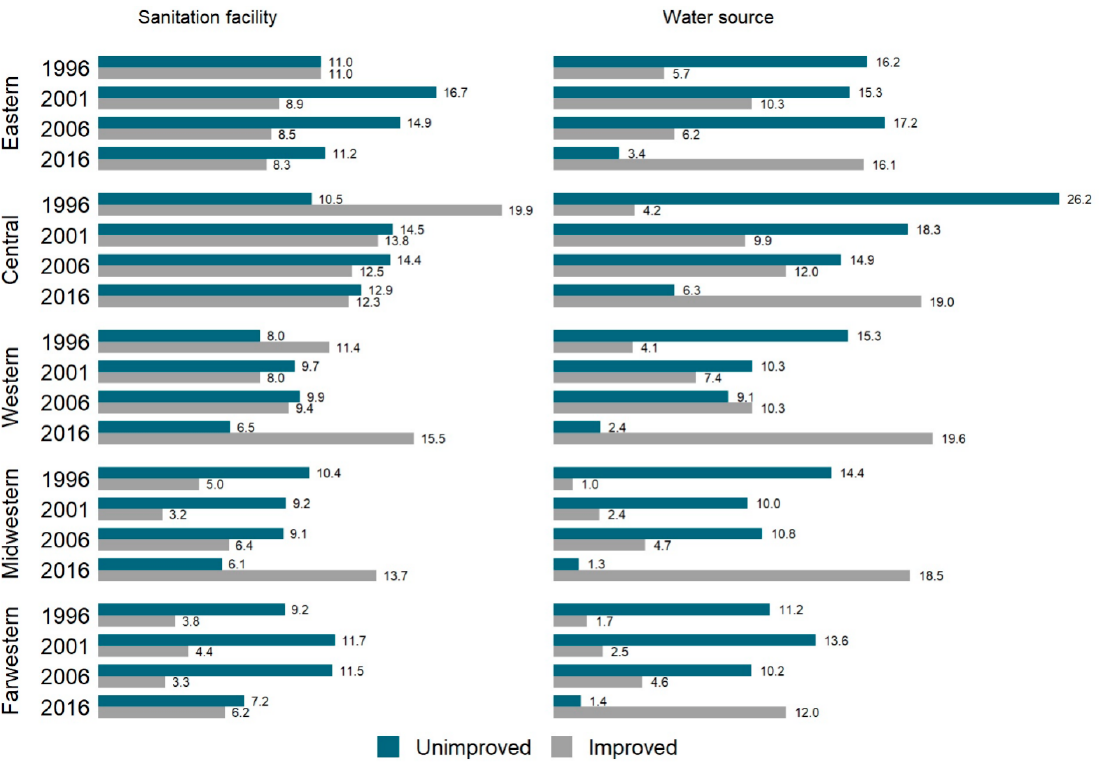
Figure 5. Trend in inequality in improved water and sanitation coverage across the developmental regions.